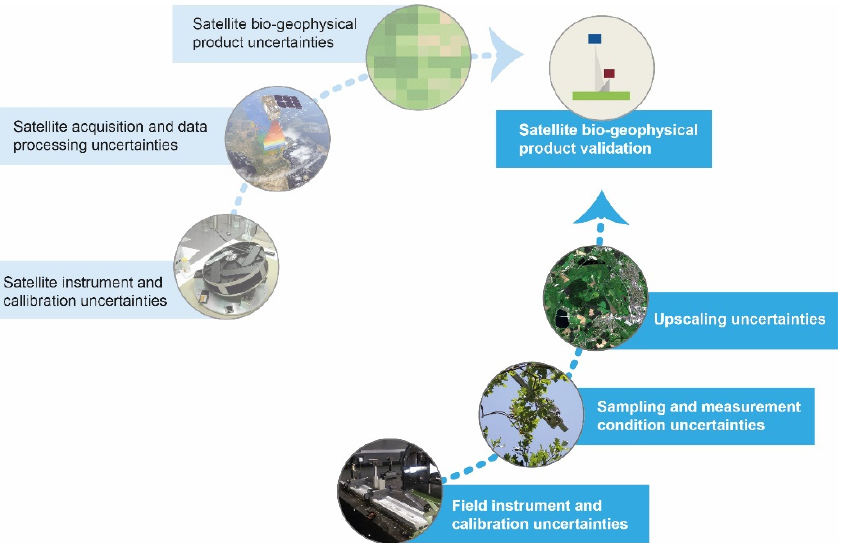
Figure 1. Diagram illustrating the use of uncertainty information for conformity testing of vegetation bio-geophysical products. The FRM4VEG project is concerned with reference data uncertainty evaluation (indicated by the bottom arrow).